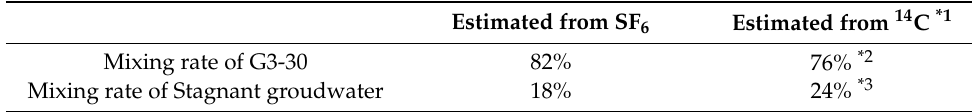
Table 3. Fresh groundwater mixing rates estimated from age